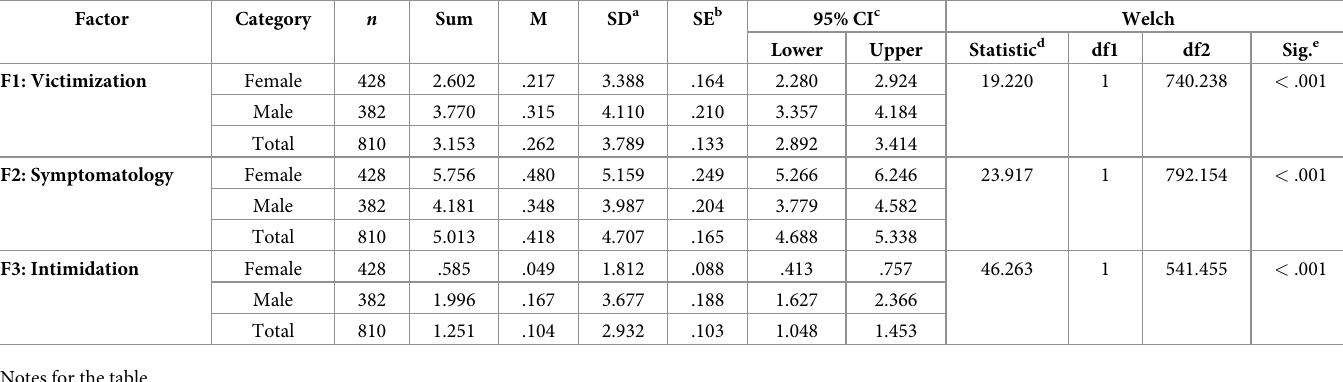
Table 5. Descriptive data, confidence intervals and Welch’s robust mean comparisons. Categorical factor: